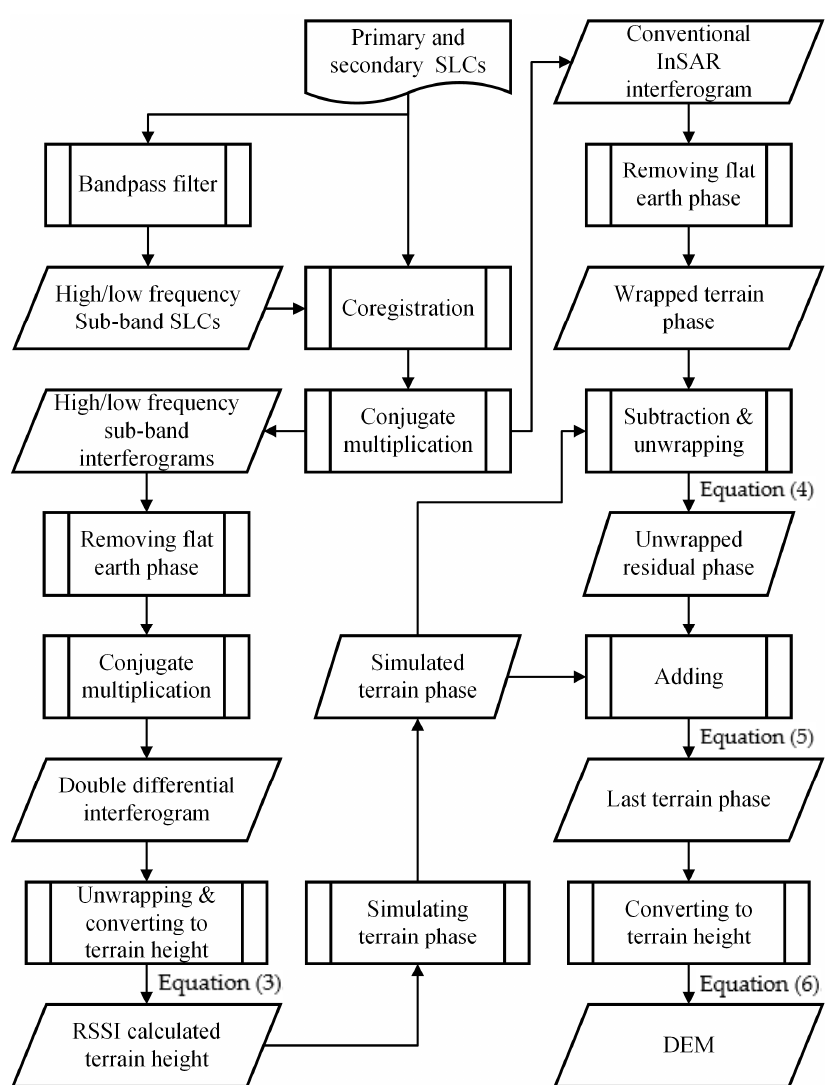
Figure 1. The implementation flowchart of the RID method.